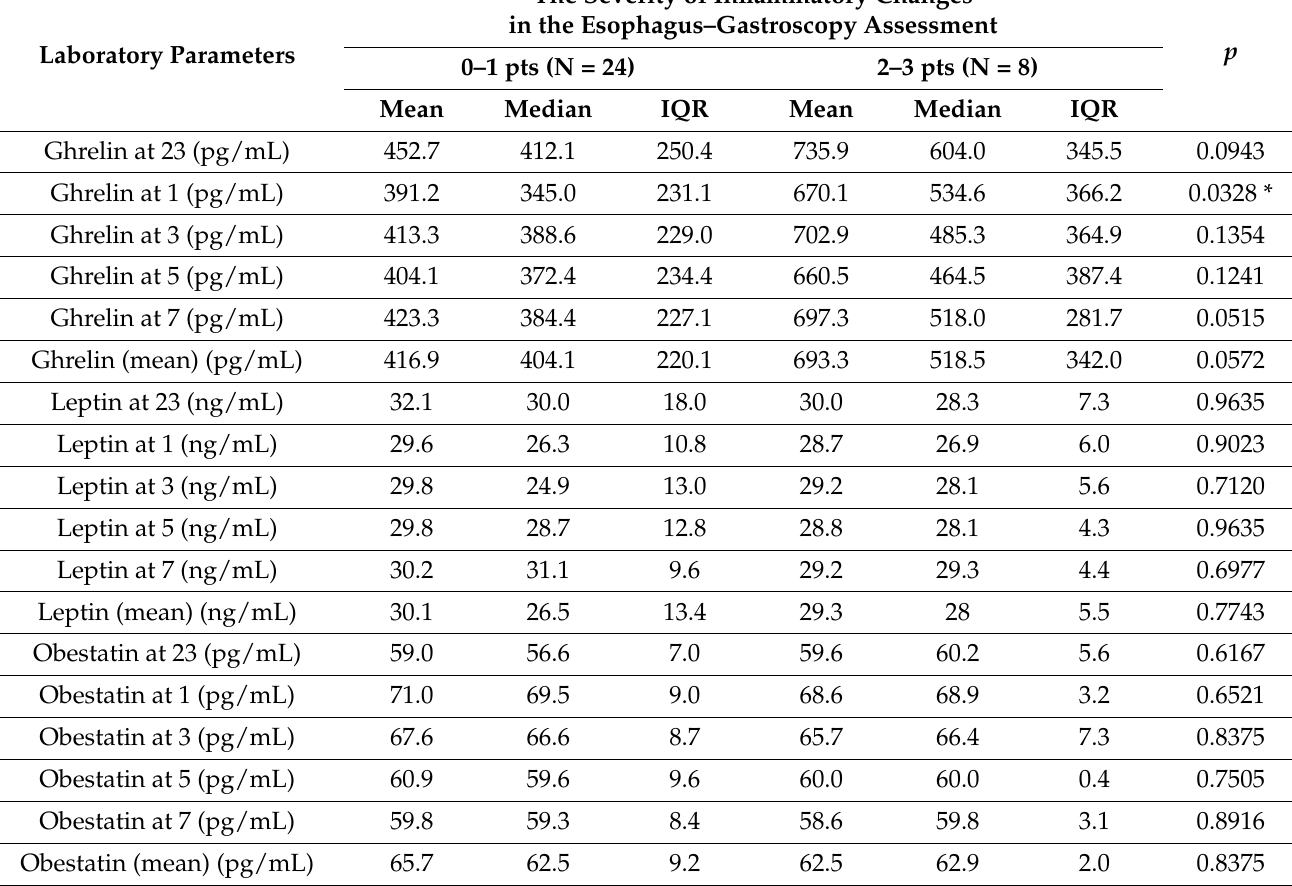
Table 6. Comparison of ghrelin, obestatin, and leptin levels depending on the severity of esophagitis (statistically significant correlations, where p < 0.05, are marked using *).